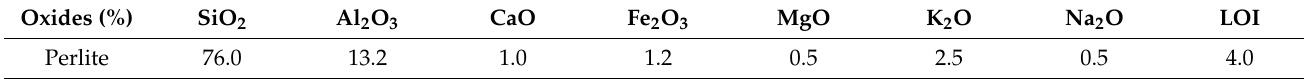
Table 3. Oxide composition of perlite.